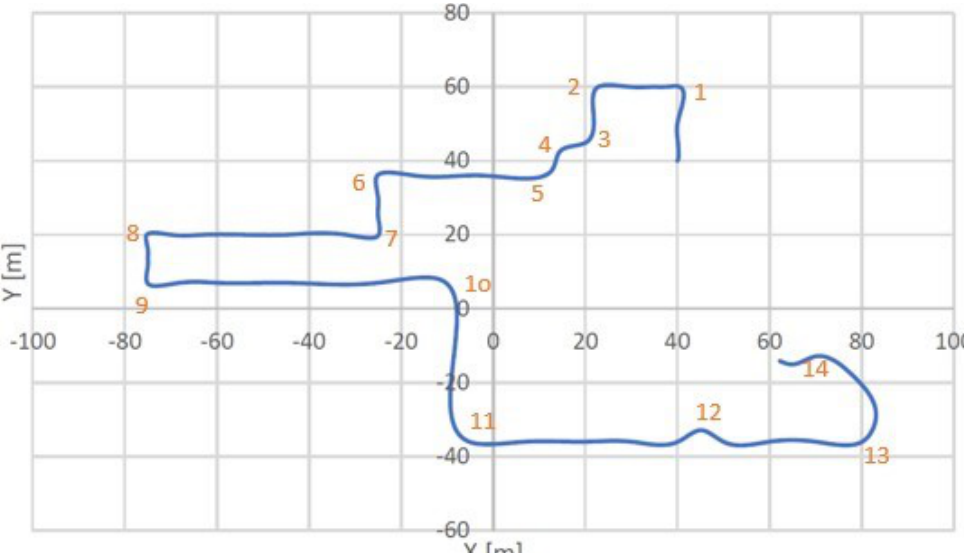
Figure 12. Reference path with identified sharp curves.